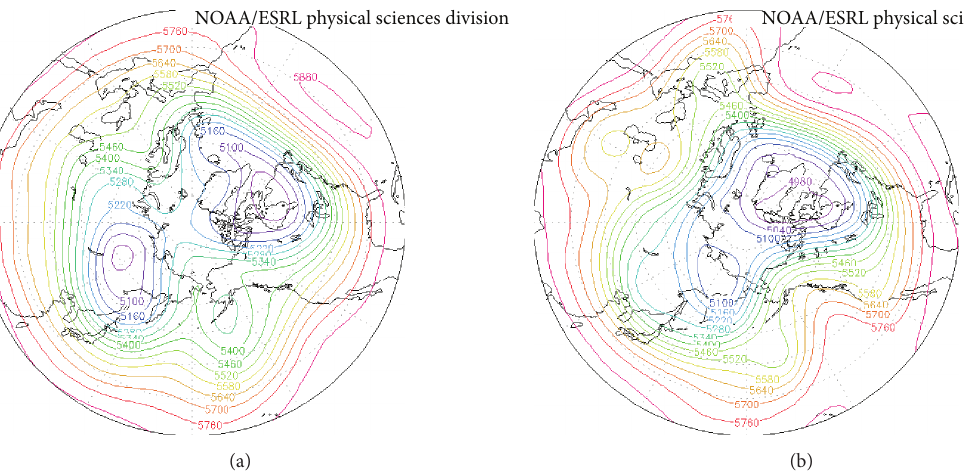
Figure 1: The mean 500 hPa height field for (a) 23 Jan to 16 Feb 2014 and (b) 21 Feb to 2 Mar 2015, showing two blocking events that dominated their respective winter seasons in the Northern Hemisphere over the East Pacific. The time period encompasses the lifetime of the Pacific Region events, and contour intervals are at a 60 m interval. These were derived using reanalysis data found at